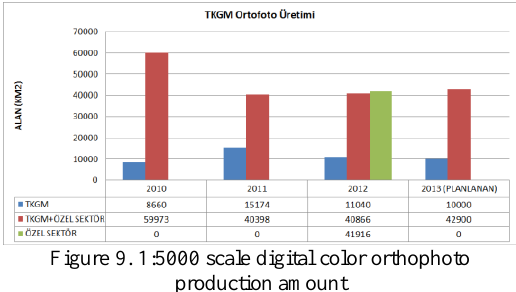
Figure 9. 1:5000 scale digital color orthophoto production amount